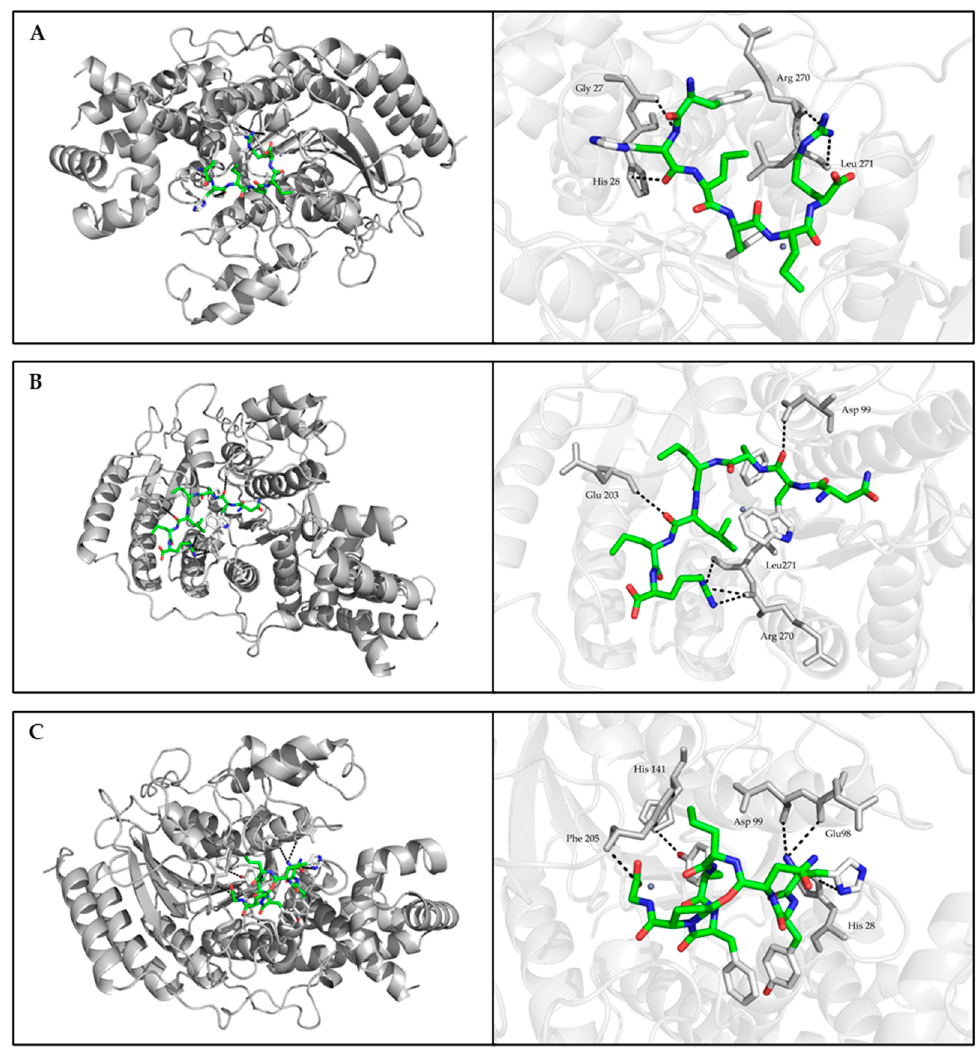
Figure 3. Best binding mode between HDAC1 and studied peptides retrieved from focused molecular docking. ( A ) FHPFPR, ( B ) NWFPLPR, ( C ) HYNPYFPGGA. The general overview was shown in the left panel. The interaction (block dotted lines) between the residues of HDAC1 (grey sticks) and peptides (green sticks) was zoomed in the right panel.